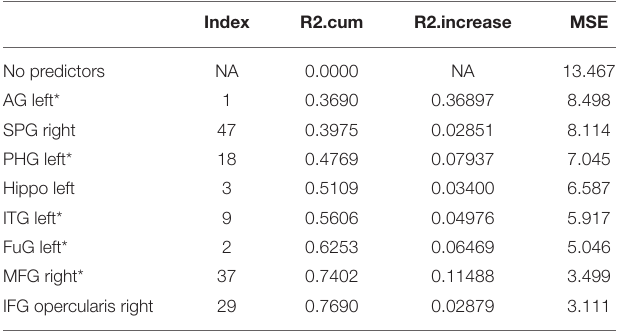
TABLE 4 | Results from a stepwise regression with the brain areas as predictors, and Trial 3 as the dependent variable.